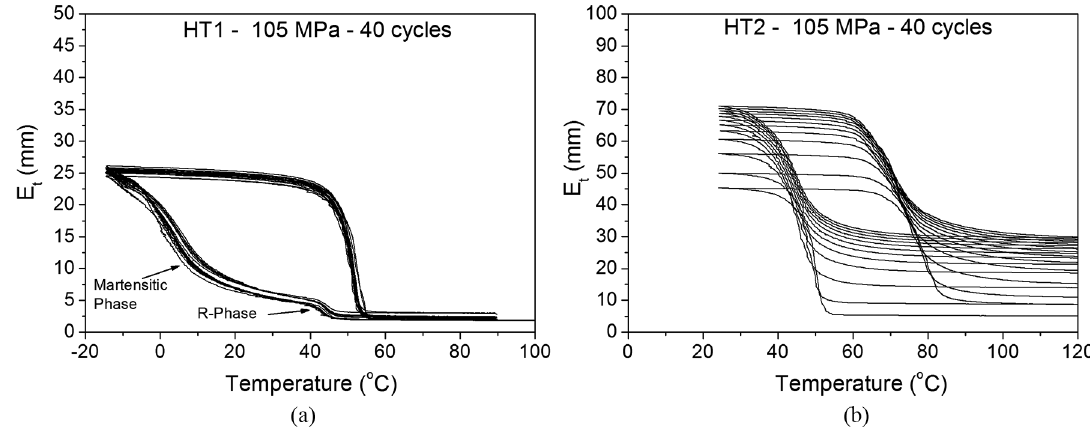
Figure 5. Thermoelastic strain versus temperature curves for tensile stress of 105 MPa, for samples: (a) HT1-24h and (b) HT2-24h.